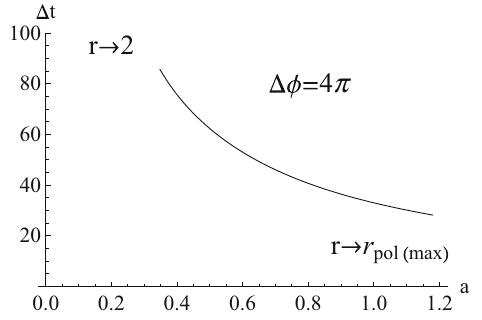
Fig. 24 Case (cid:4)φ = 4 π. The shape of such orbits represents second picture in Fig.